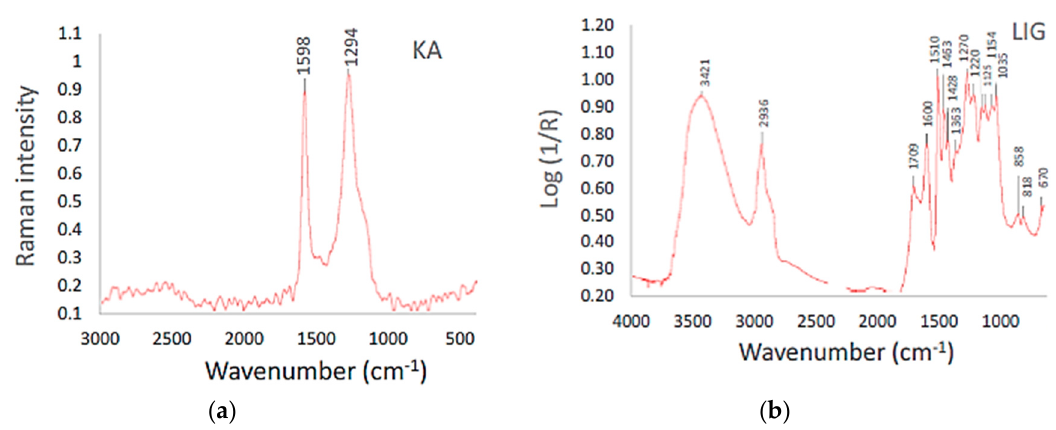
Figure 6. Raman and infrared spectra of coke breeze ( a ) and lignin ( b ).